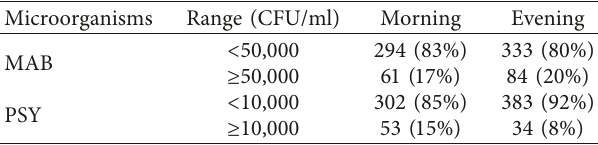
Table 4: Percentage of samples according to the quality standards of the industry and milking dayshift (morning and evening) for mesophilic aerobic bacteria (MAB) and psychrotrophic bacteria